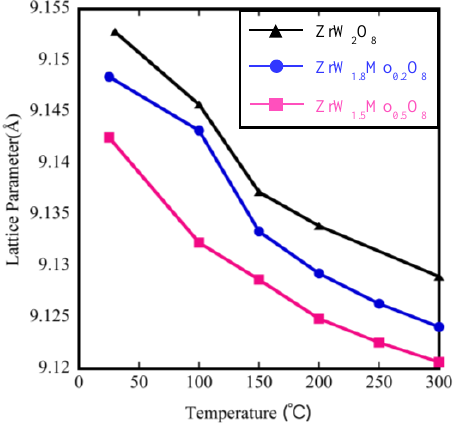
Figure 9. Lattice parameters of ZrW 2 − x Mo x O 8 . Table 4. High temperature (HT)-X-ray powder diffraction (XRD) calculated NTE coefficients for ZrW 2 − x Mo x O 8 .